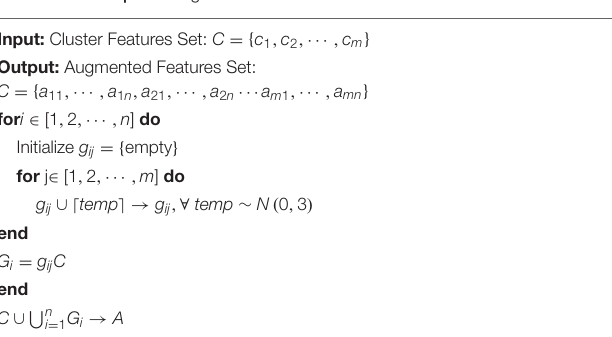
ALGORITHM 1 | Data